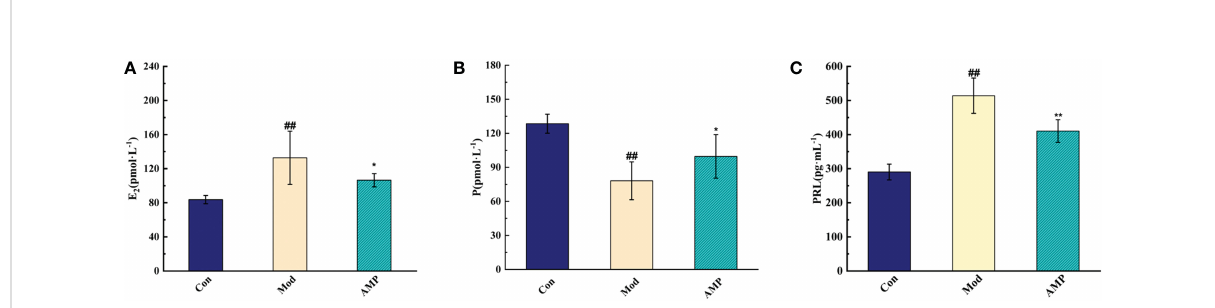
FIGURE 2 Effect of AMP on serum indexes of MGH rats, n = 6 (A) , effect of AMP on E 2 of MGH rats; (B) , effect of AMP on P of MGH rats; (C) , effect of AMP on PRL of MGH rats). Compared with Con group, # represents P < 0.05, ## represents P < 0.01; Compared with Mod group, * represents P < 0.05, ** represents P <